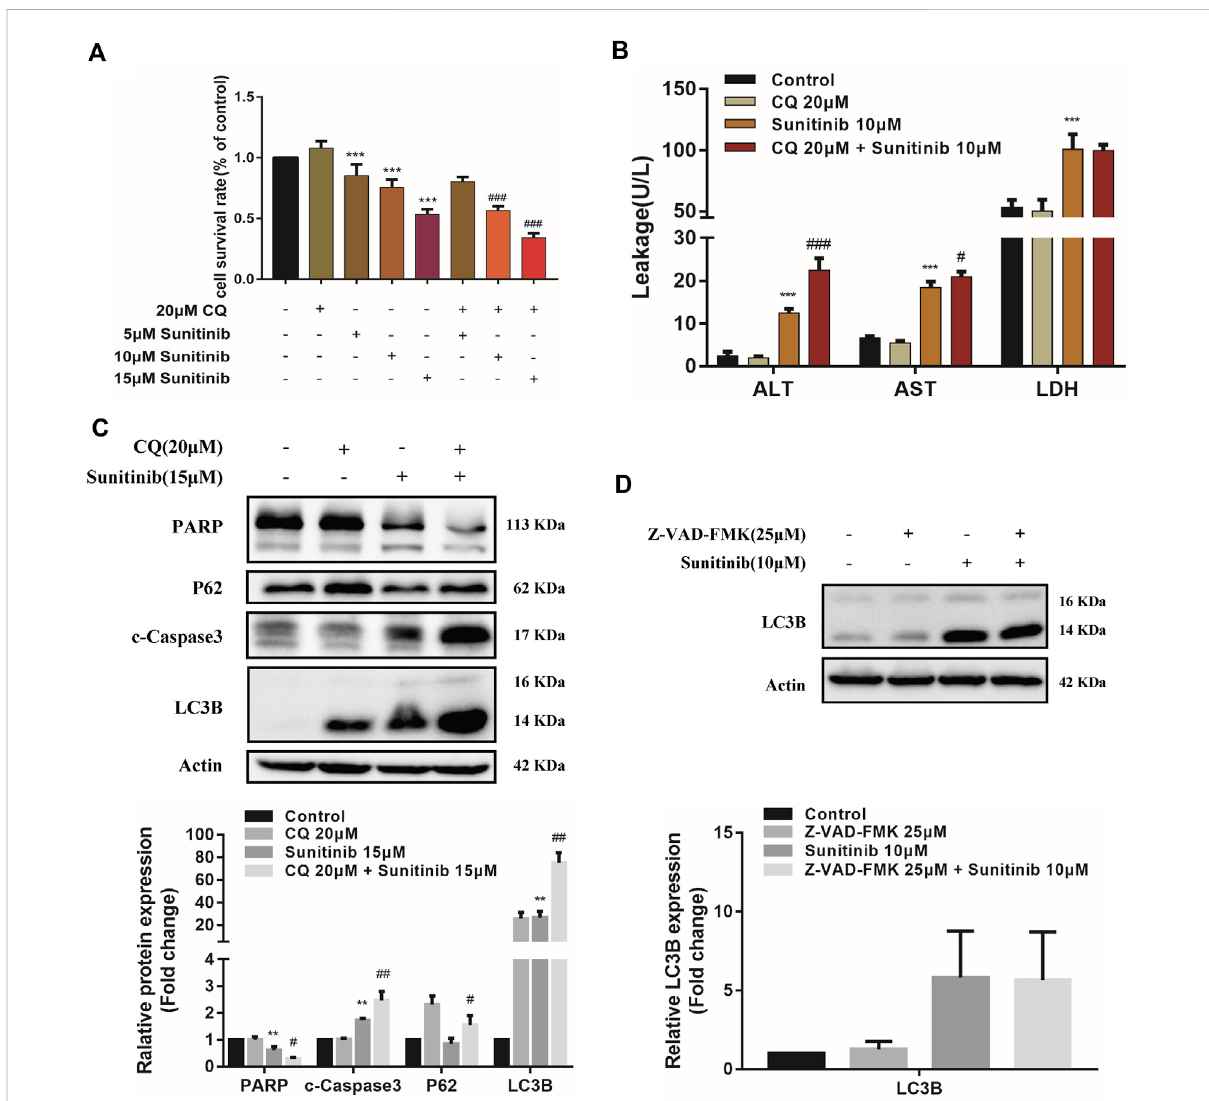
FIGURE 3 The interaction between apoptosis and autophagy. (A) The viability of hepatocytes was analyzed by MTT after L02 cells were incubated with 5, 10, 15 μ M Sunitinib for 48 h in the presence or absence of 20 μ M CQ pretreatment for 2 h ( n = 6). (B) Levels of ALT, AST, and LDH released into the supernatant after L02 cells were incubated with 10 μ M Sunitinib for 48 h in the presence or absence of 20 μ M CQ pretreatment for 2 h ( n = 3). (C) Protein expression of PARP, c-Caspase3, P62, and LC3B ( n = 3). (D) Protein expression of LC3B after L02 cells were incubated with 10 μ